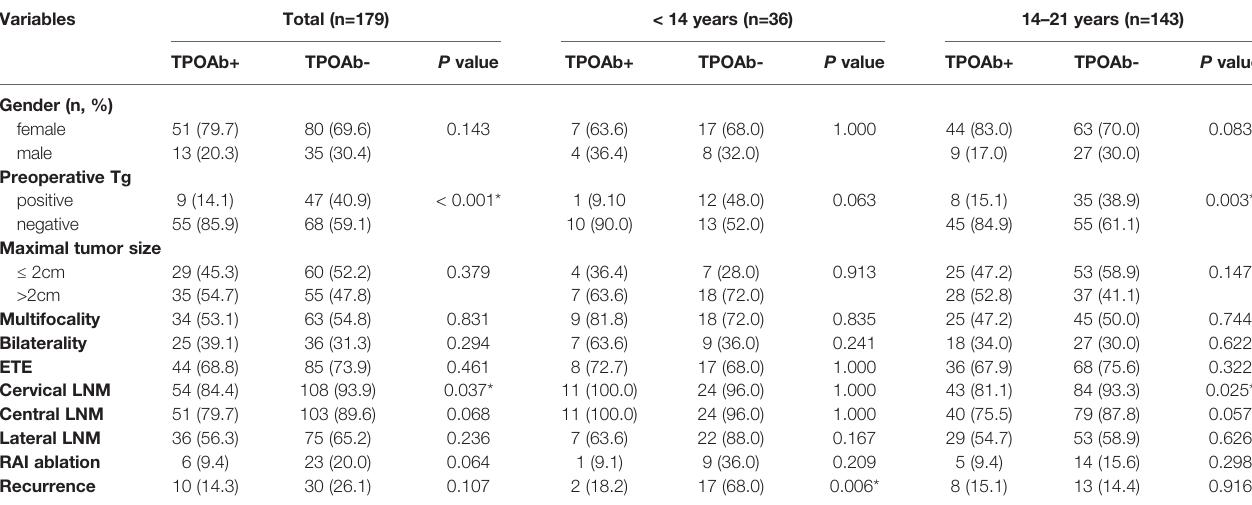
TABLE 3 | Clinicopathologic features of PTC patients with positive and negative TPOAb in different age groups. Variables Total (n=179) < 14 years (n=36) 14 – 21 years (n=143) TPOAb+ TPOAb- P value TPOAb+ TPOAb- Gender (n, %) female 51 (79.7) positive 9 (14.1) ≤ 2cm